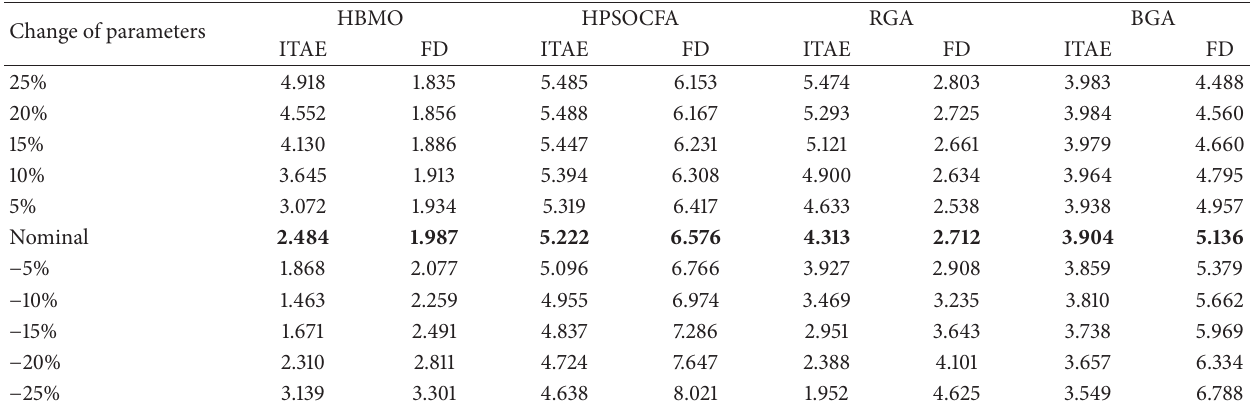
Figure 8: Deviation of frequency; (a) area 1, (b) area 2, (c) area 3, and (d) area 4 for +25% change of parameters; solid (IABC), dashed (HPSOCFA), dashed dotted (RGA), and dotted (BGA). Table 5: ITAE and FD in serial number 1 for scenario I in Case